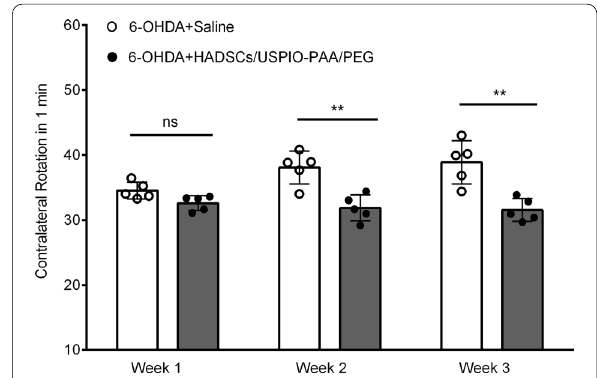
Fig. 7 PD rat models were administered with either saline or USPIO-PAA/PEG-labeled HADSCs in the ipsilateral striatum impaired with 6-OHDA, and the rotation numbers per min were scored and compared. There is significant reduction of the rotation numbers in the 2nd, 3rd weeks after the PD rats receiving HADSCs, as compared to the corresponding PD rats receiving saline. ns indicates insignificant change, and ** indicates p < 0.01. n 5 for each =